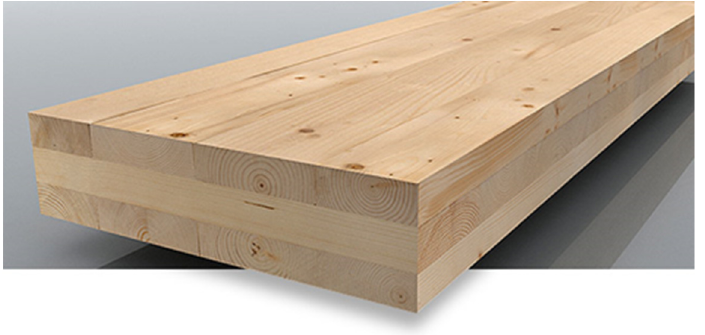
Figure 1. Common cross-section of the three-layer CLT panel (source: https://wigo.info/cross- laminated-timber; accessed on 29 December 2022).